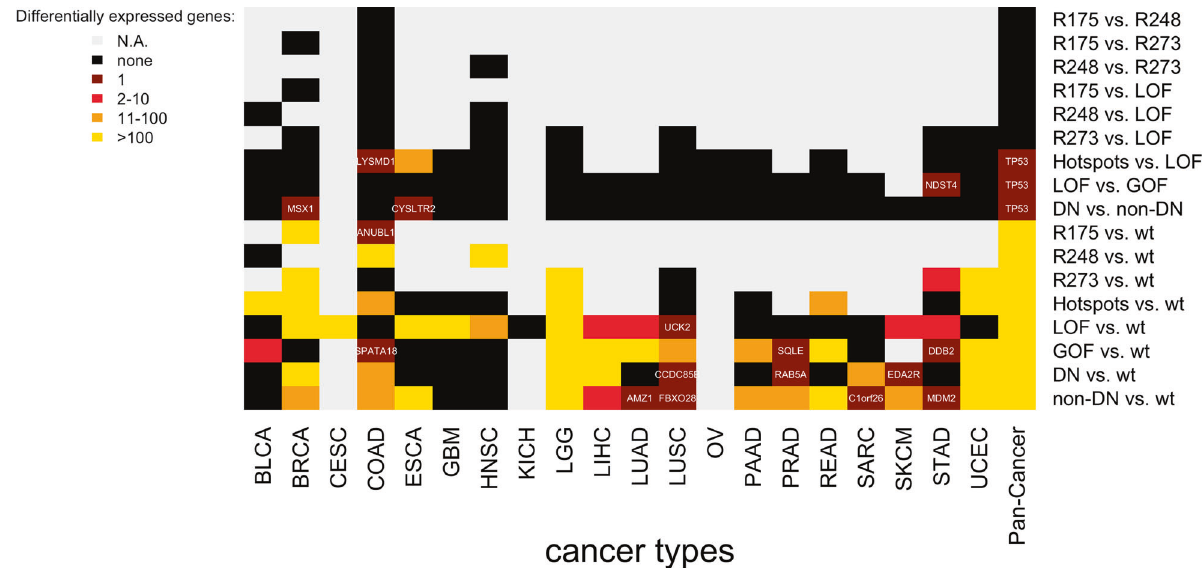
Fig. 2 Gene expression patterns associated with GOF, LOF, DN, and non-DN TP53 mutations. For each analysis in a speci fi c cancer type, 15 samples of a TP53 mutation class were compared to 15 samples of another mutation class. For the pan-cancer analysis, the results for speci fi c cancer type were summarized using Fisher ’ s method. None = no signi fi cantly expressed genes detected, N.A. = analysis not possible (insuf fi cient number of samples). Hotspots = pool of the 10 most abundant TP53 missense mutations in the study cohort (R175H, R273C/H, R248Q/W, R282W, Y220C, G45S, H179R, and